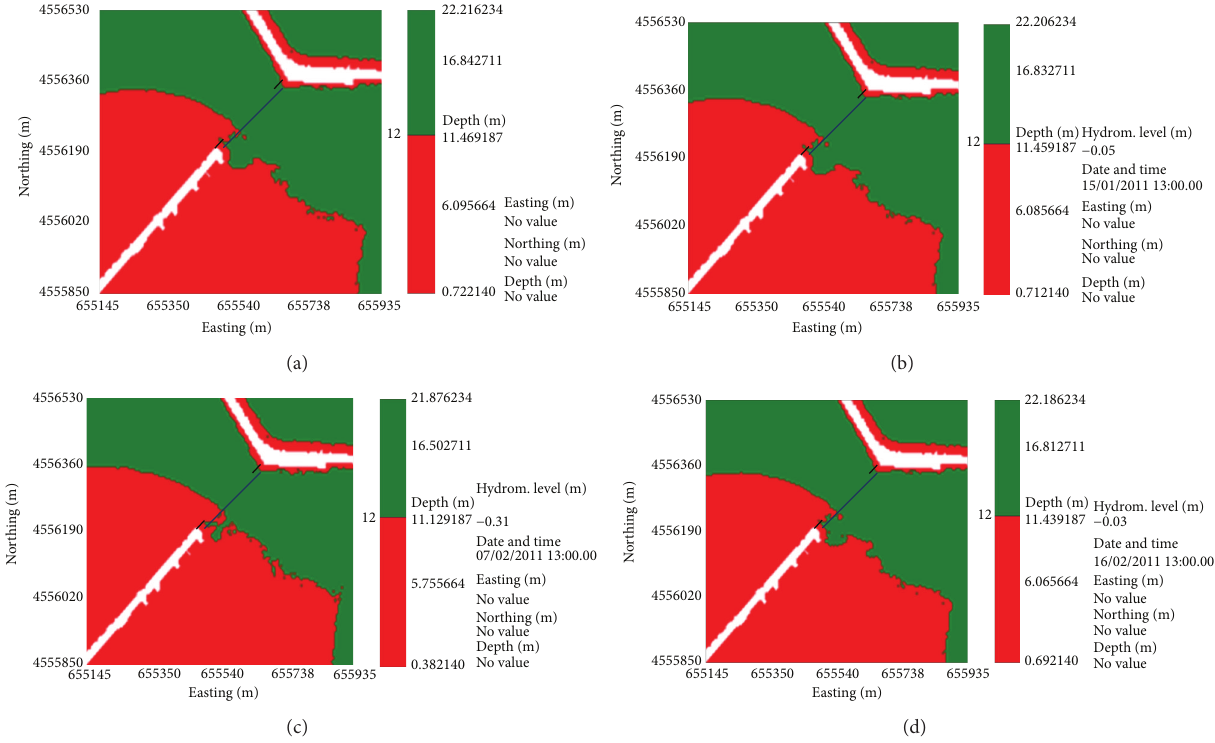
Figure 10: Dynamic bathymetry of Port of Bari. The blue line represents the acoustic subsystem while the two black lines represent the magnetic subsystem. Red areas are zones with water depth under 12m (not controllable with acoustic subsystem configured with operative quote of 12m) while green areas are zones with water depth above 12 m. (a) represent the static analysis of the area, (b) the area before the event, (c) during the event, and (d) after the